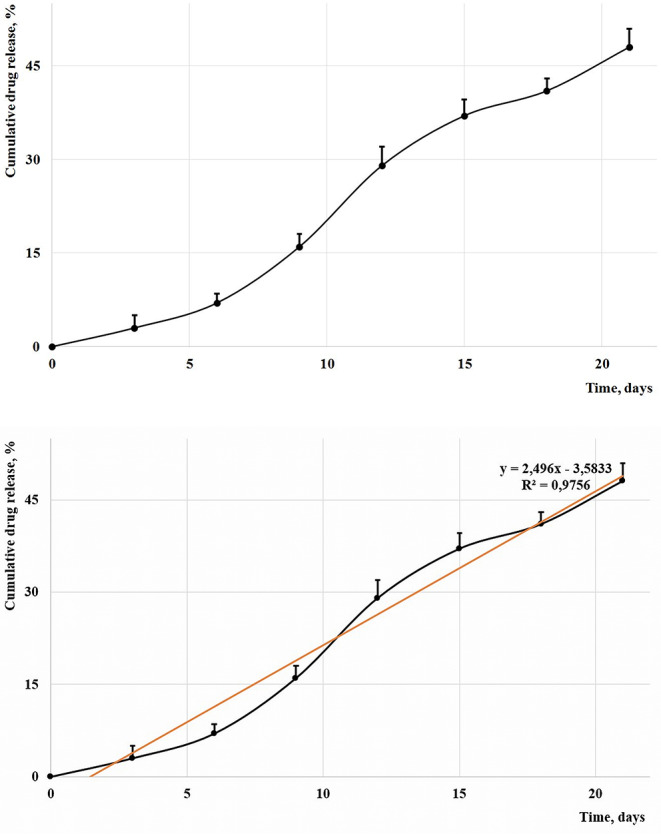
The cumulative release of isosorbide derivatives.